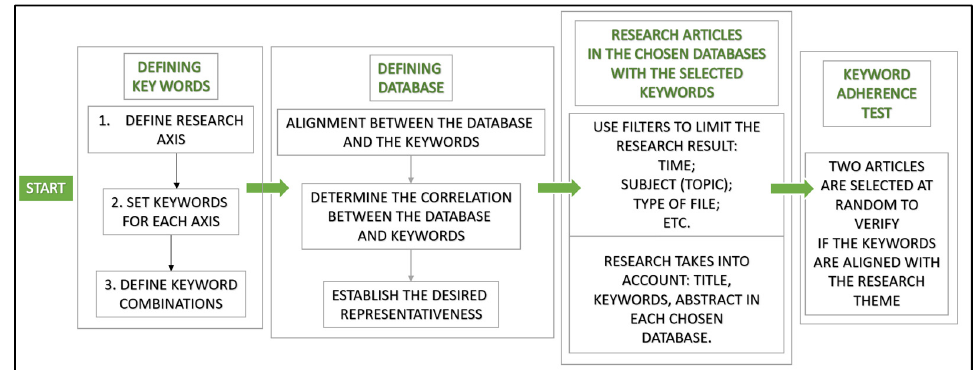
Figure 3. ProKnow-C method adapted from [18]. Description of Phase 1–Setting up an FRA-data- base.